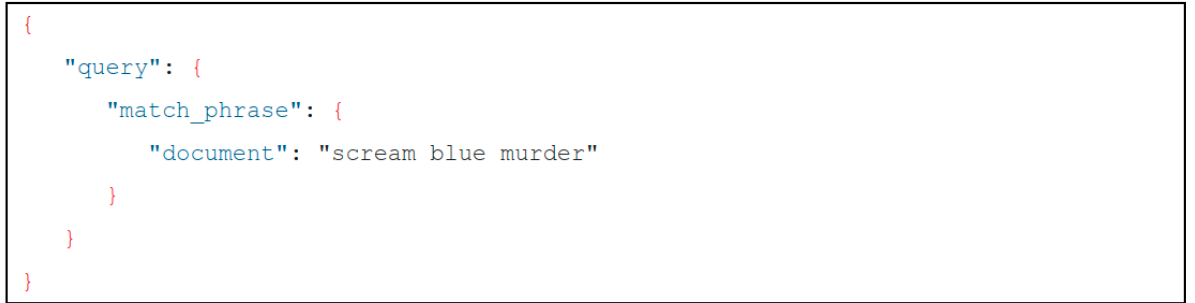
Figure 3. An example of a match_phrase query.